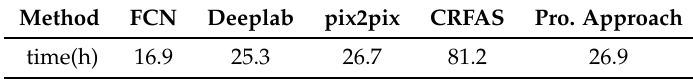
Table 8. Training time of ESAR